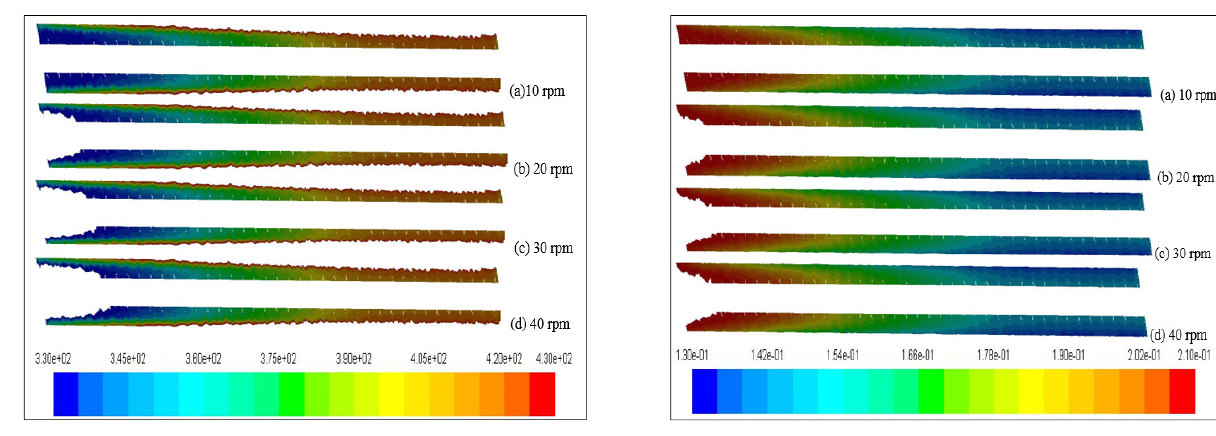
Fig. 4. Temperature Contour plane at 250 gm.